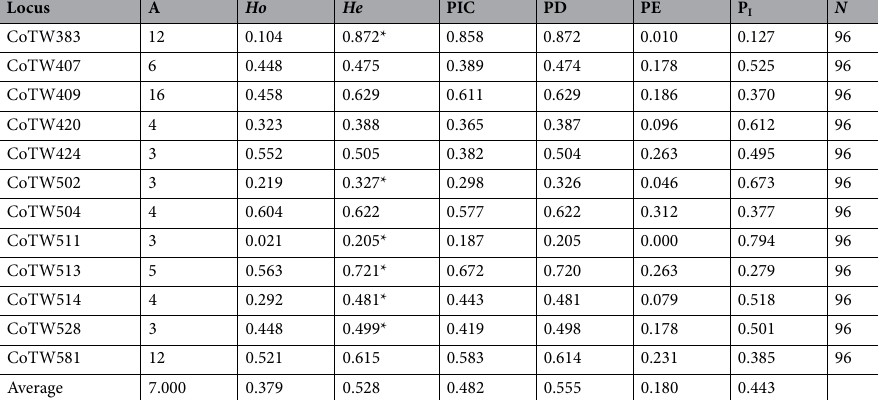
Table 4. Genetic characterization of 12 polymorphic EST-SSR loci of Chamaecyparis taiwanensis . A number of alleles, Ho observed heterozygosity, He expected heterozygosity, PIC polymorphism information content or power of information content, PD power of discrimination, PE power of exclusion or probability of exclusion, P I probability of identity, PD is equal to 1 − P I , N number of individuals. *Highly significant from Hardy– Weinberg equilibrium ( P < 0.001).